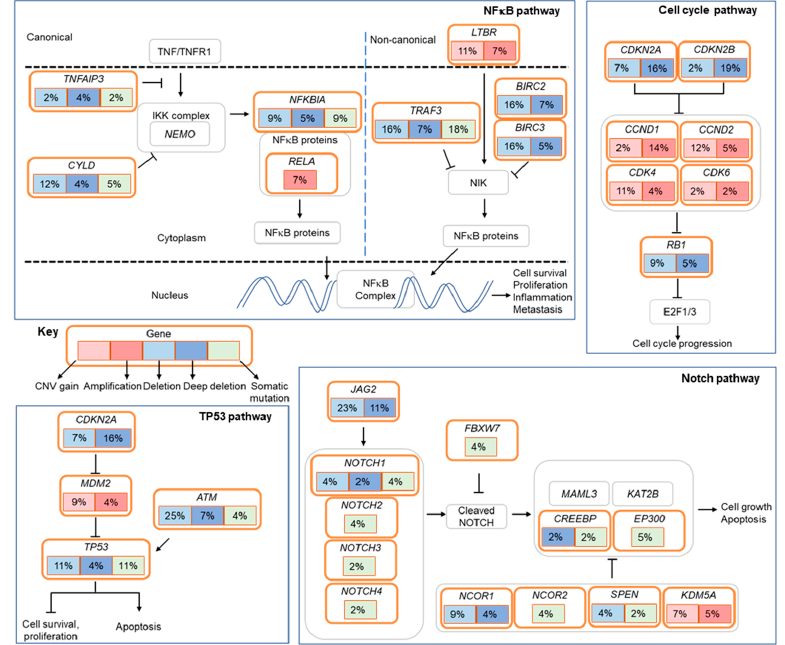
Figure 4. Altered pathways in pulmonary lymphoepithelioma-like carcinoma. Frequencies (%) of